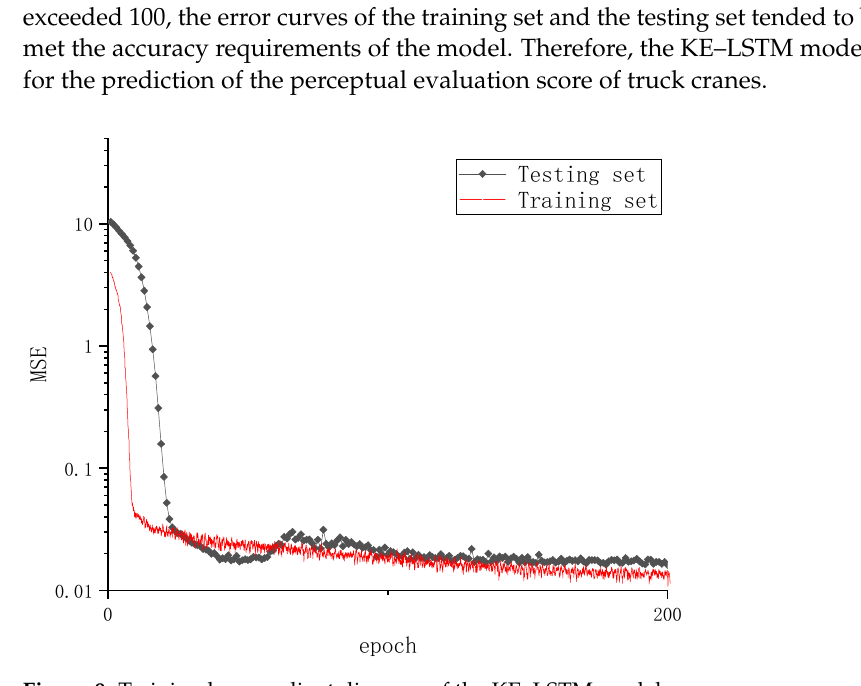
Figure 9. Training loss gradient diagram of the KE–LSTM model.